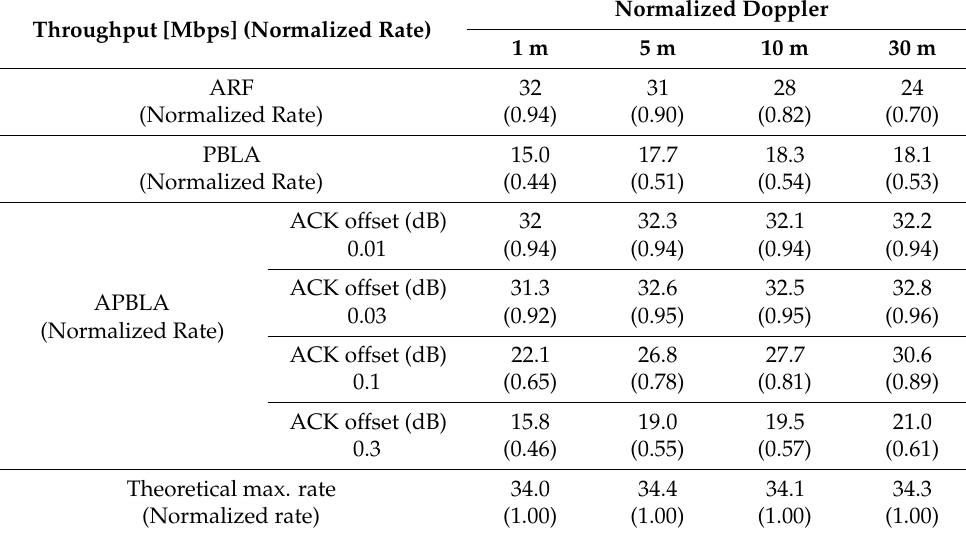
Table 2. Performance comparison